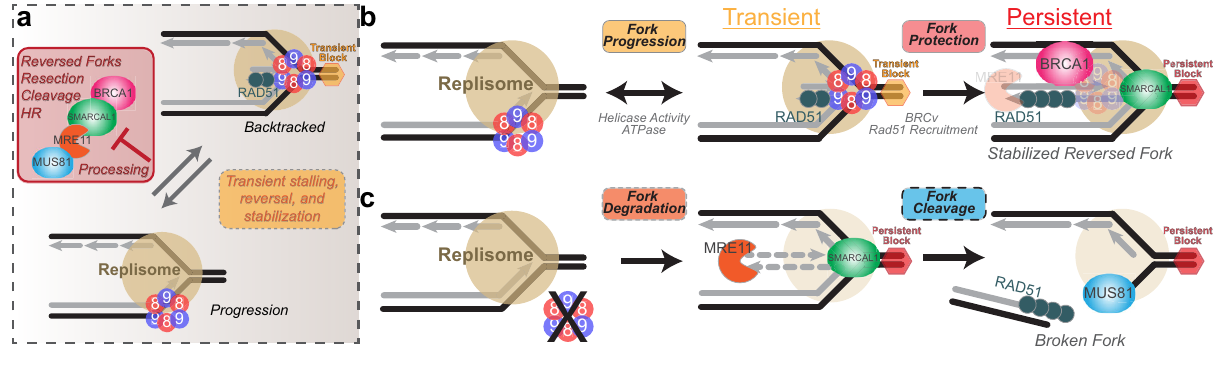
Fig. 8 | A model for MCM8/9 aiding in normal fork progression or directing reversedforkprotectionduringpersistent obstacles.a MCM8and9participate within the replisome to overcome transient blocks (yellow hexagon) to fork pro- gression and limit fork processing to maintain genomic integrity. b Should the replisome encounter persistent blocks (red hexagon), MCM8/9 works to recruit